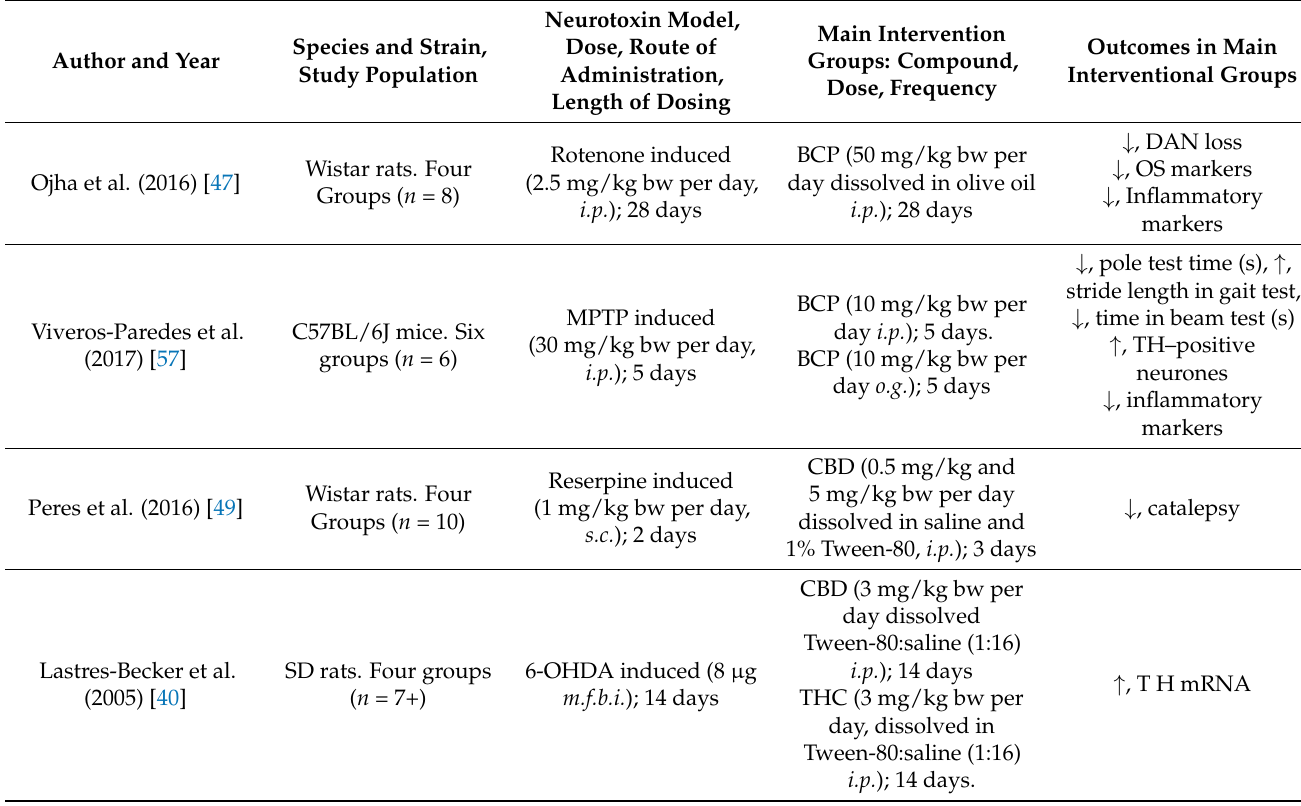
Table 2. Study characteristics and outcome